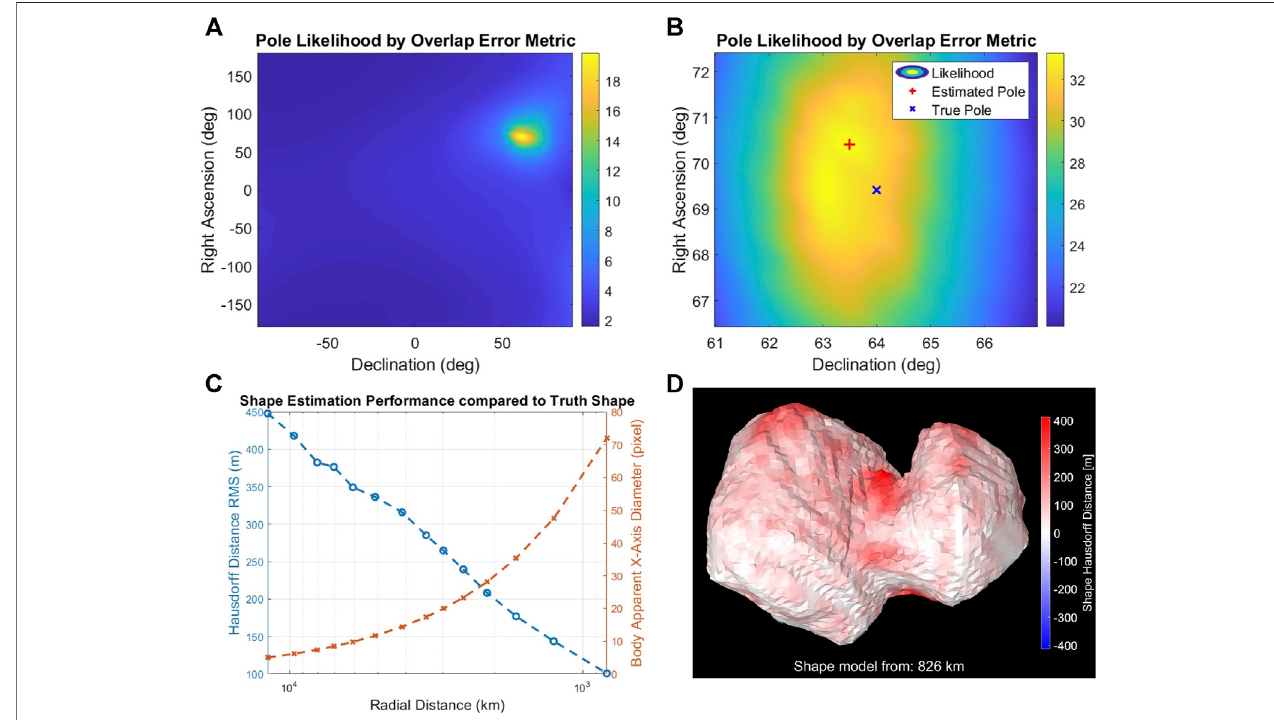
FIGURE 3 | Pole likelihood evaluated at 10 ° (A) and 0.5 ° (B) intervals at a distance of 826 km from the body. (C,D) Performance of shape-from-silhouette as a function of the body-image span (D) and errors in the reconstructed visual hull (i.e., Hausdorff distance) at 826